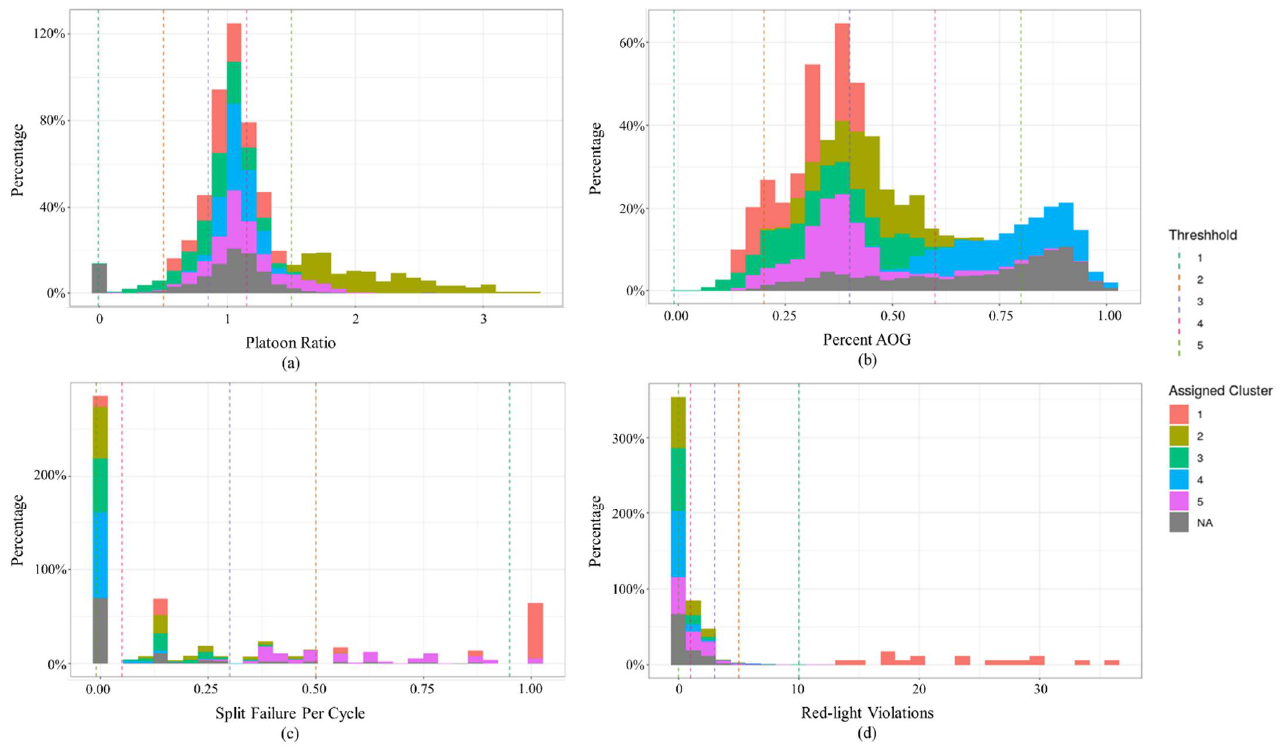
Figure 3. Clustering and threshold values: ( a ) platoon ratio: ( b ) percent arrivals on green (AOG); ( c ) ( c ) split failure per cycle; ( d ) red-light split failure per cycle; ( d ) red-light violations.